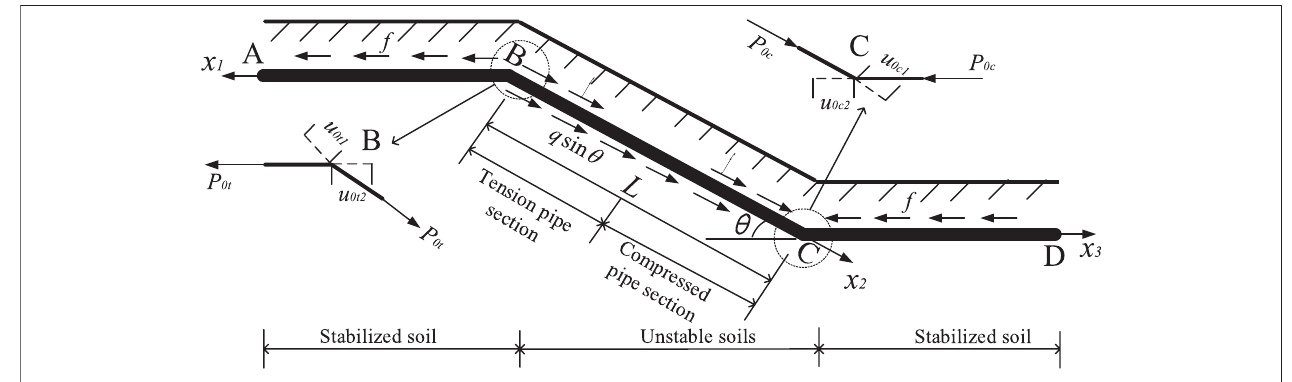
FIGURE 3 | A side view of the pipeline sections subjected to the thawing landslide of soil.